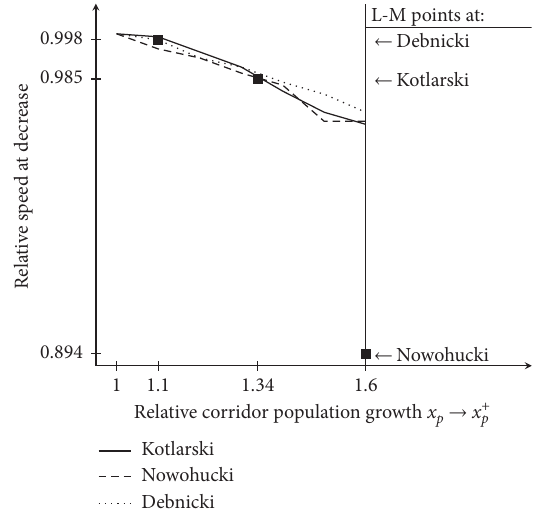
Figure 6: Relative speed decrease at alternative bridges against corridor population